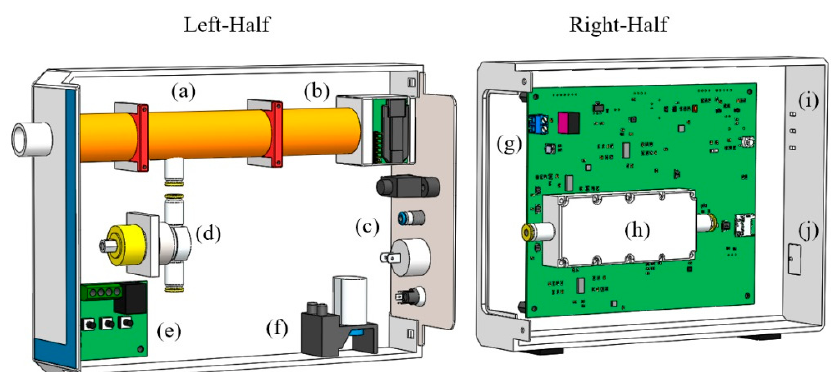
Figure 2. Internal layout of WOLF Breath E-nose components: ( a ) Sampling tube; ( b ) Sensor module;